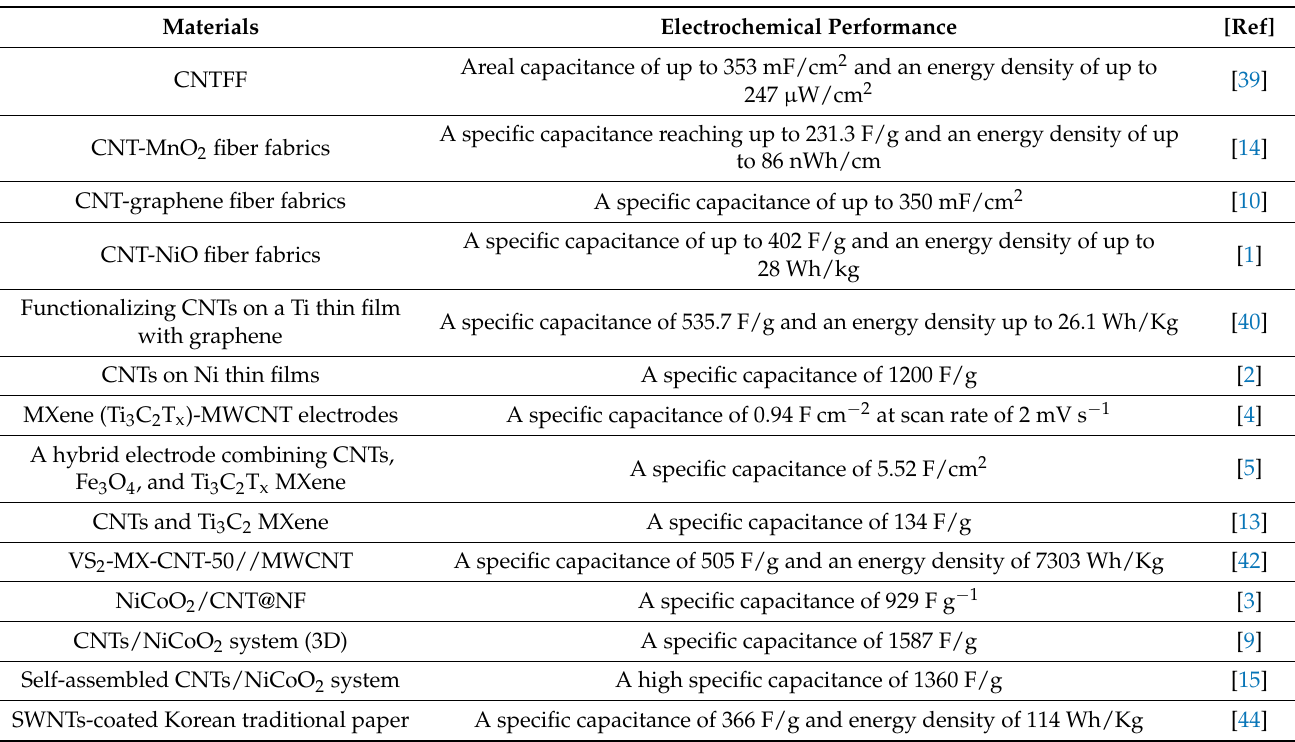
Table 1. A summary of the various types of CNTs and their electrochemical